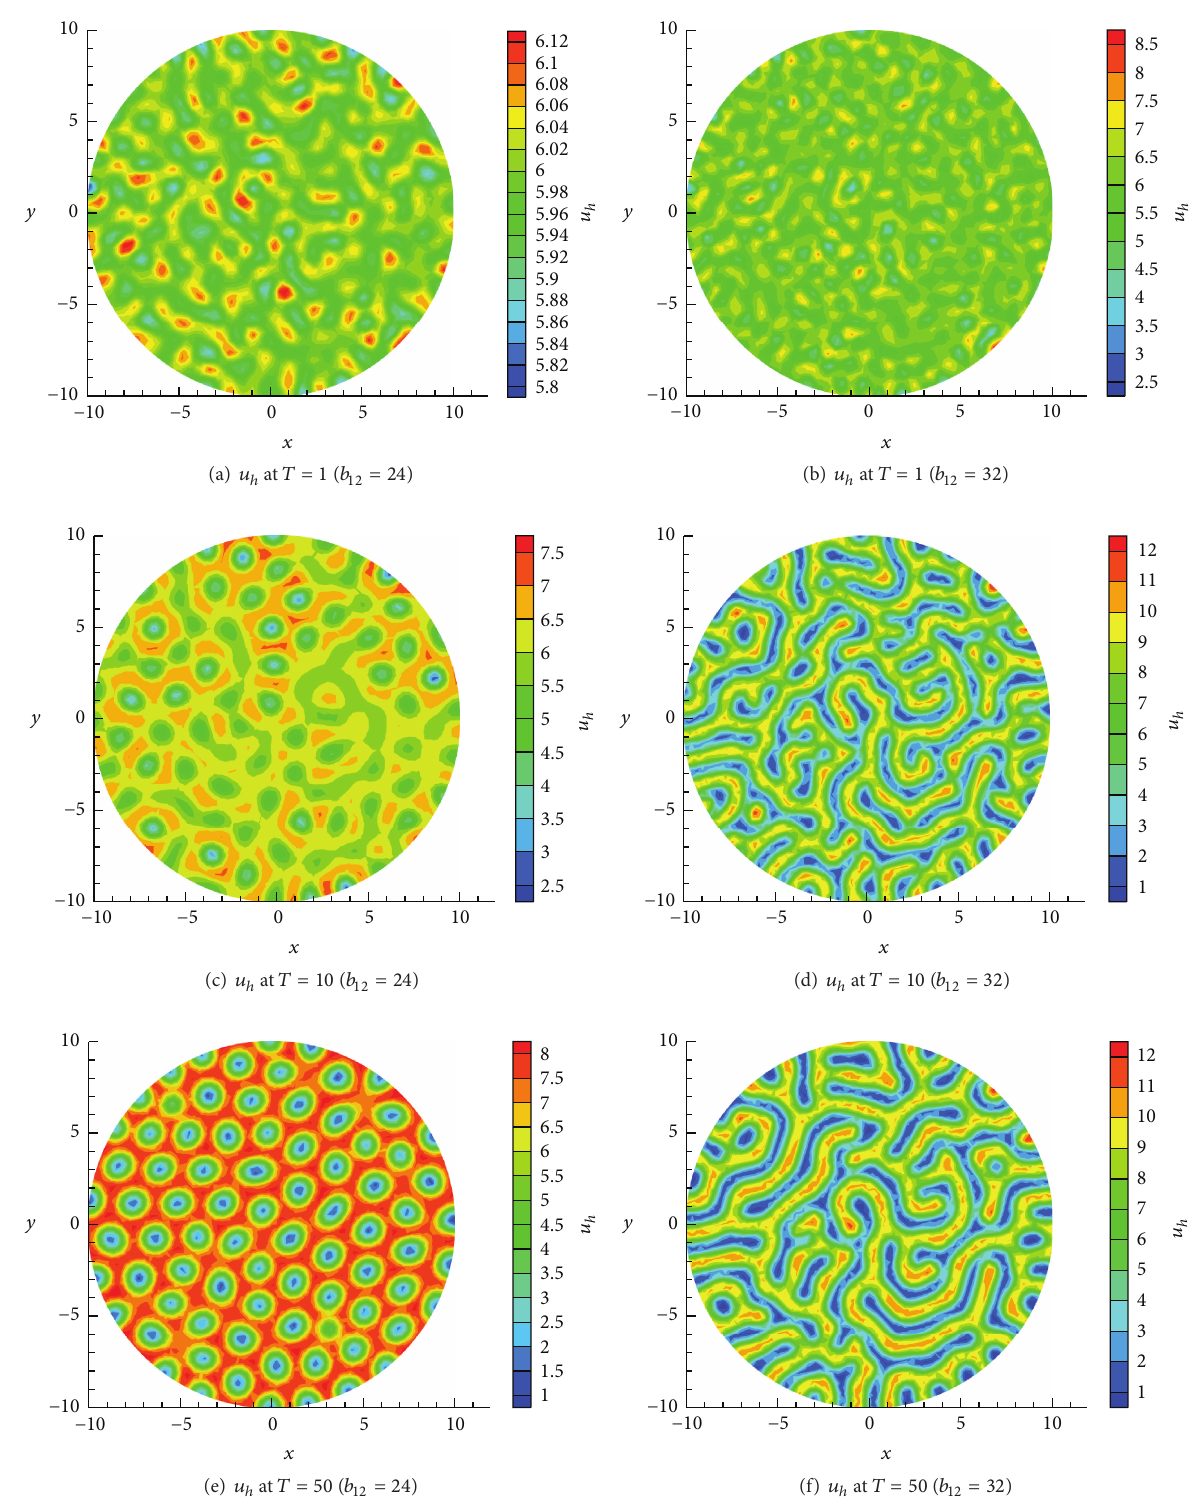
Figure 9: The time evolution of 𝑢 ℎ for 𝑏 12 = 24 (left) and 𝑏 12 = 32 (right) on the circular